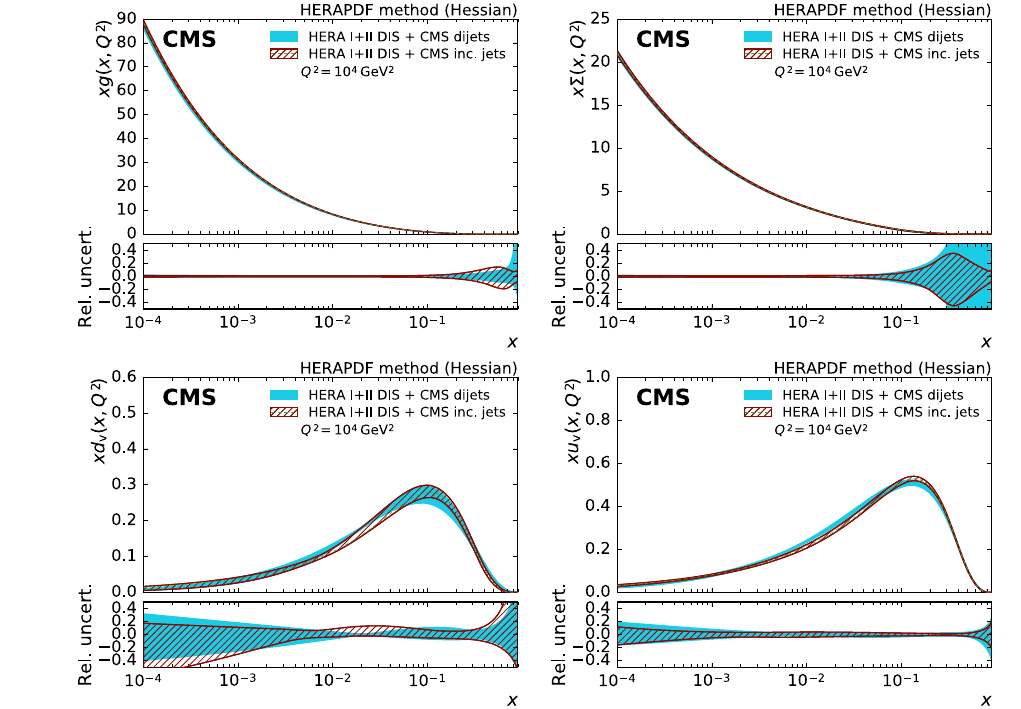
Fig. 11 The gluon (top left), sea quark (top right), d valence quark (bottom left), and u valence quark (bottom right) PDFs as a function of x as derived from a fit of HERA inclusive DIS data in combination